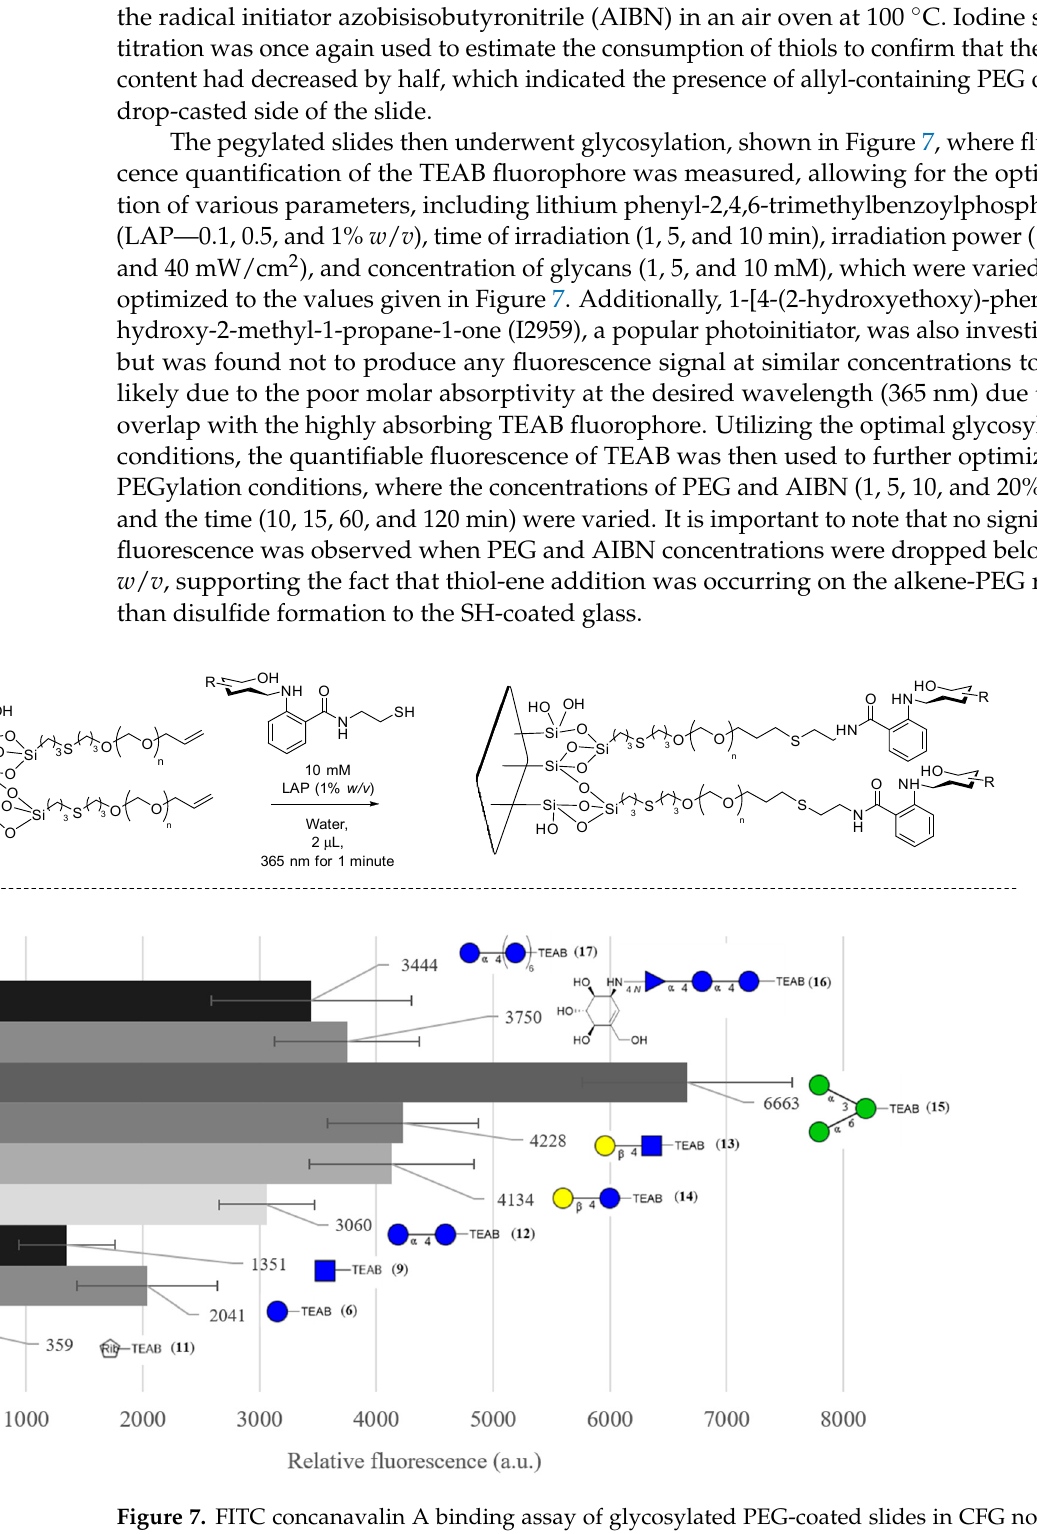
Figure 7. FITC concanavalin A binding assay of glycosylated PEG-coated slides in CFG notation, with error bars denoting 95% confidence intervals ( n = 3). Blank is defined as a non-glycosylated region of the slide measured at the same time.